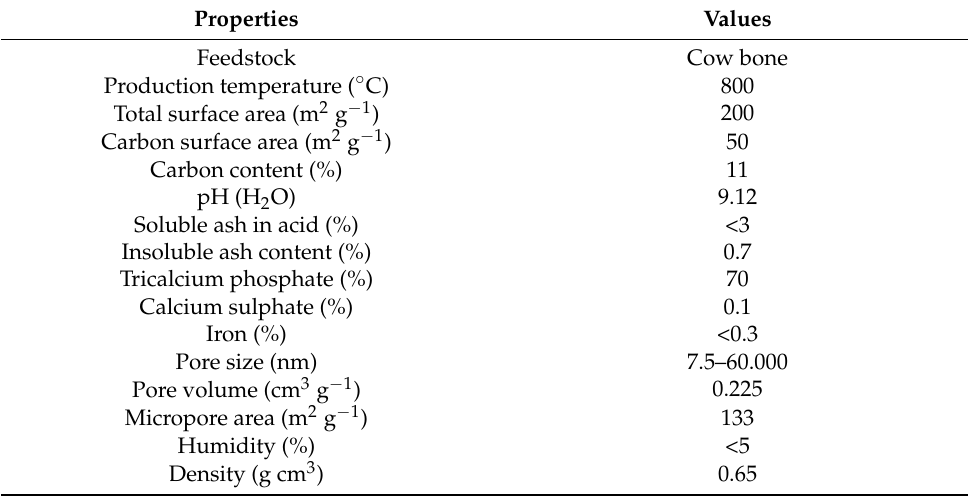
Table 2. Selected properties of the